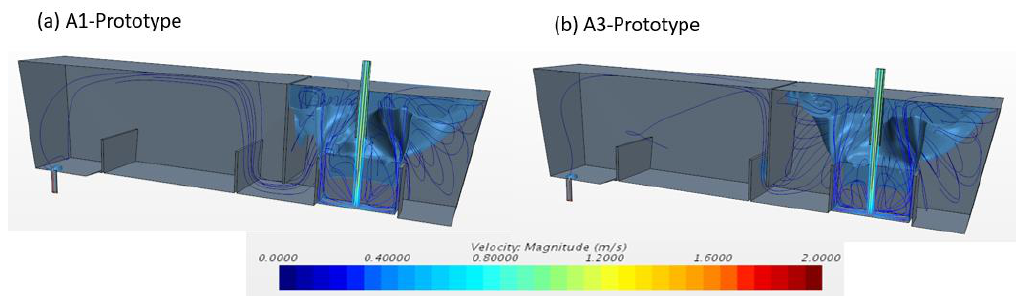
Figure 11. Calculated streamline and isosurface of turbulence kinetic energy ( k = 0.0045 J kg −1 ) by CFD modelling for two cases: ( a ) A1-Prototype; ( b ) A3-Prototype.